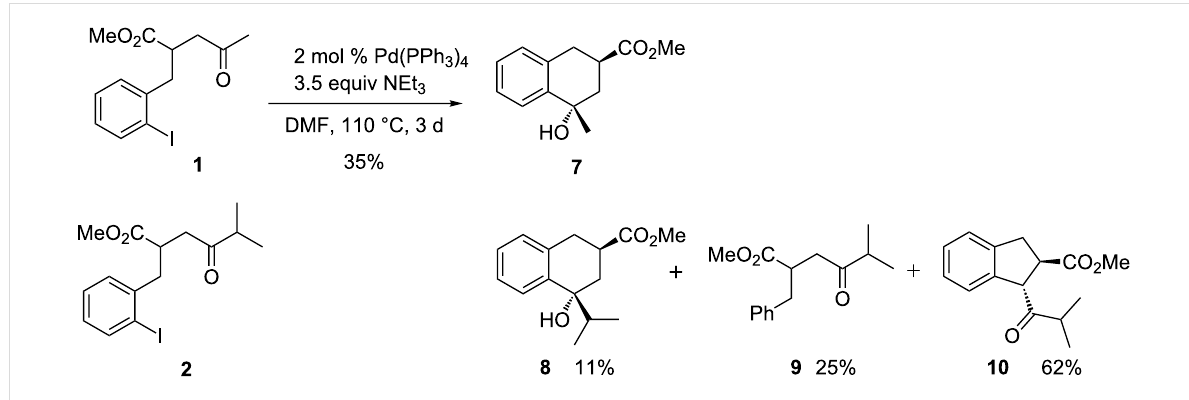
Scheme 3: Palladium-catalyzed reactions of methyl ketone 1 to tetralin derivative 7 and of isopropyl-substituted ketone 2 to compounds 8 , 9 and 10 .